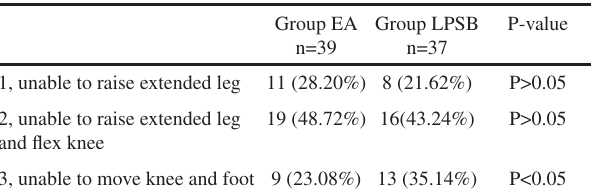
Table 3 - Degree of motor block (modified Bromage Score Scale) expressed as number of patients and percentage per